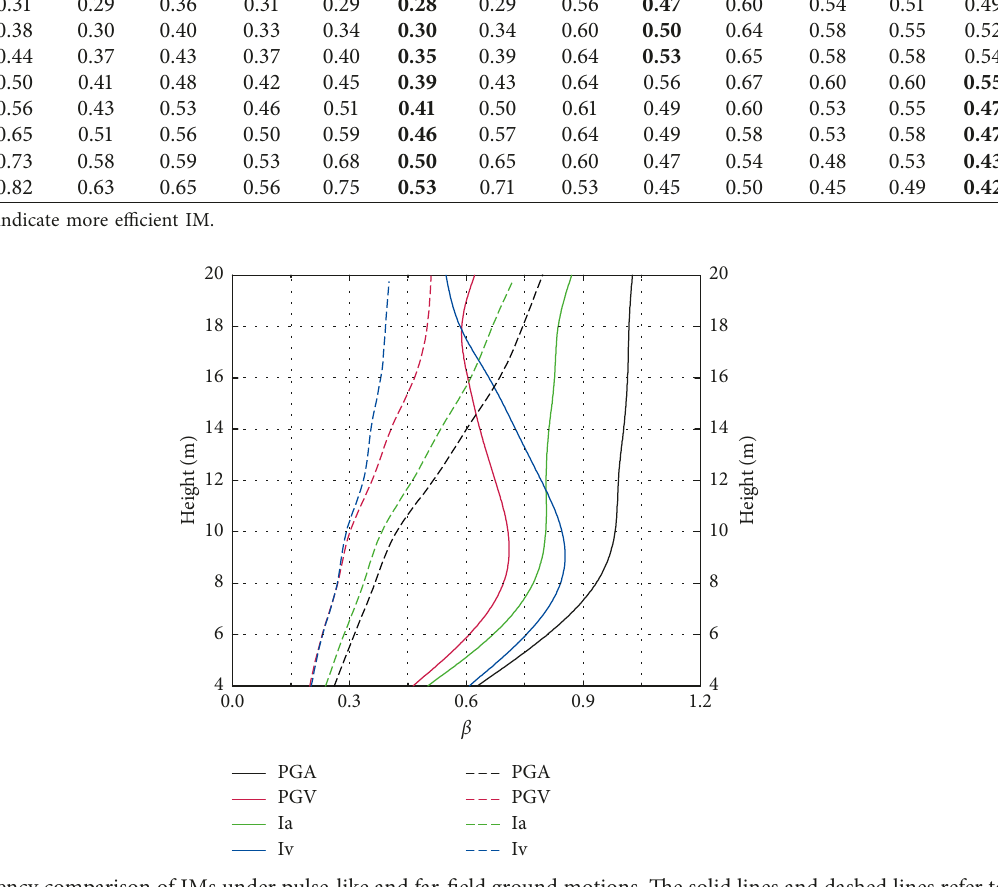
Figure 13: Efficiency comparison of IMs under pulse-like and far-field ground motions. The solid lines and dashed lines refer to the cases under pulse-like and far-field ground motions,